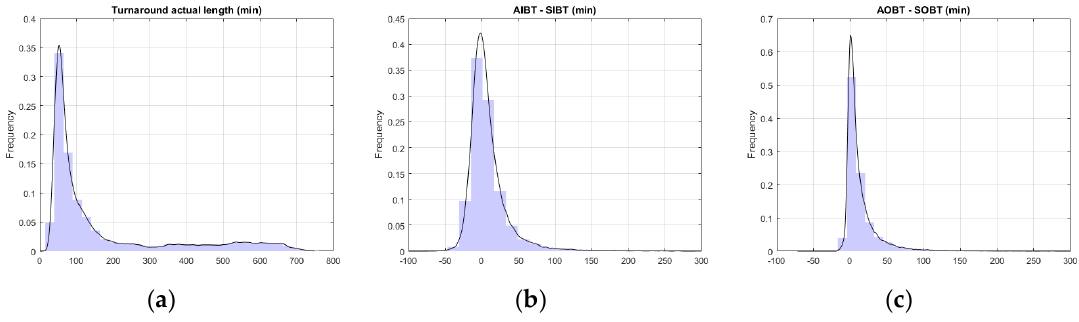
Figure 8. Histogram and distribution fitting for ( a ) actual taxi-out time (min) and ( b ) wind intensity (kts).